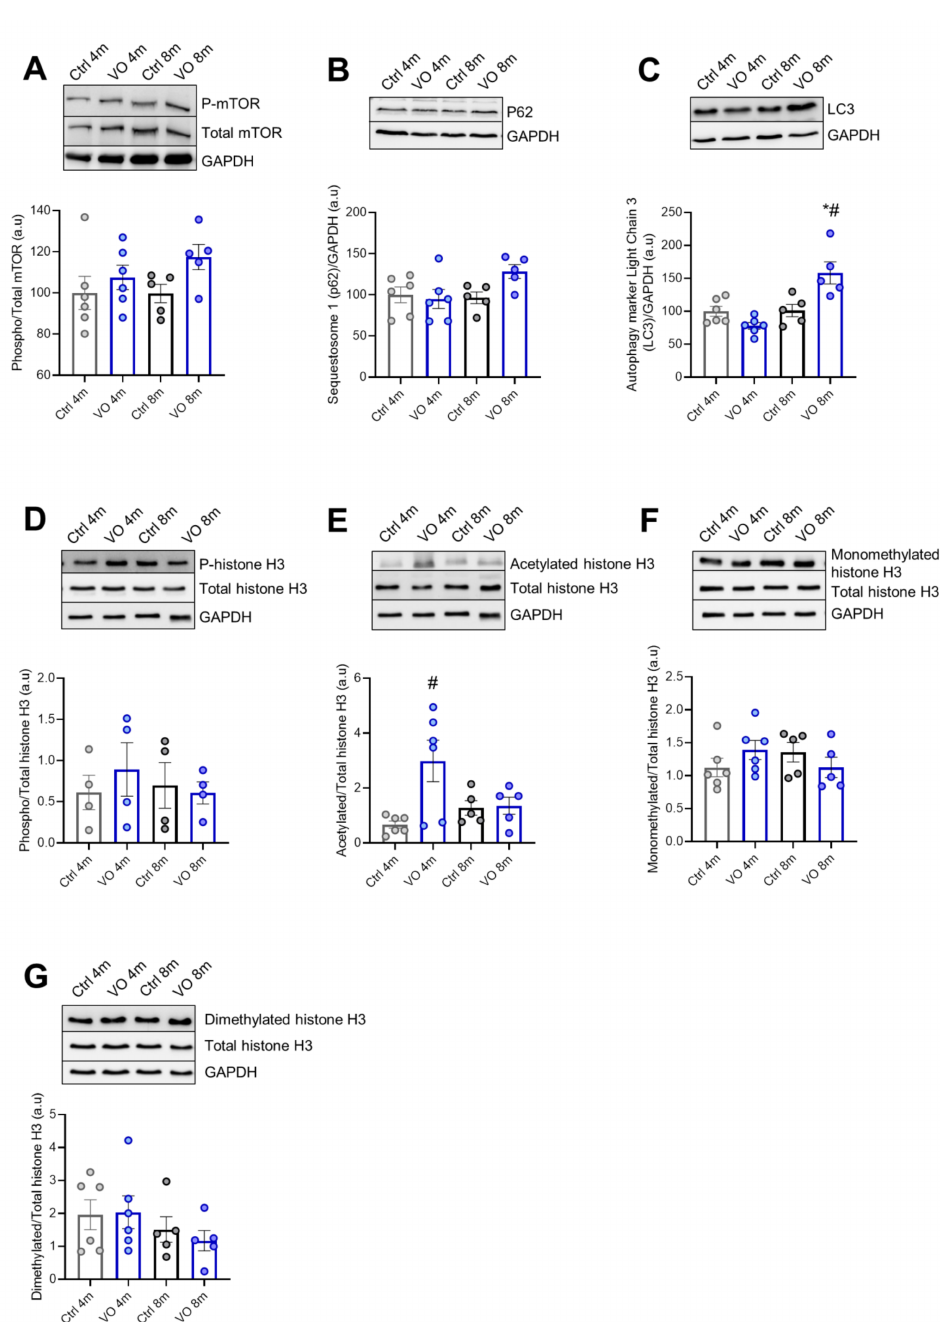
Figure 3. Downstream signaling pathway of cardiac hypertrophic growth and histone